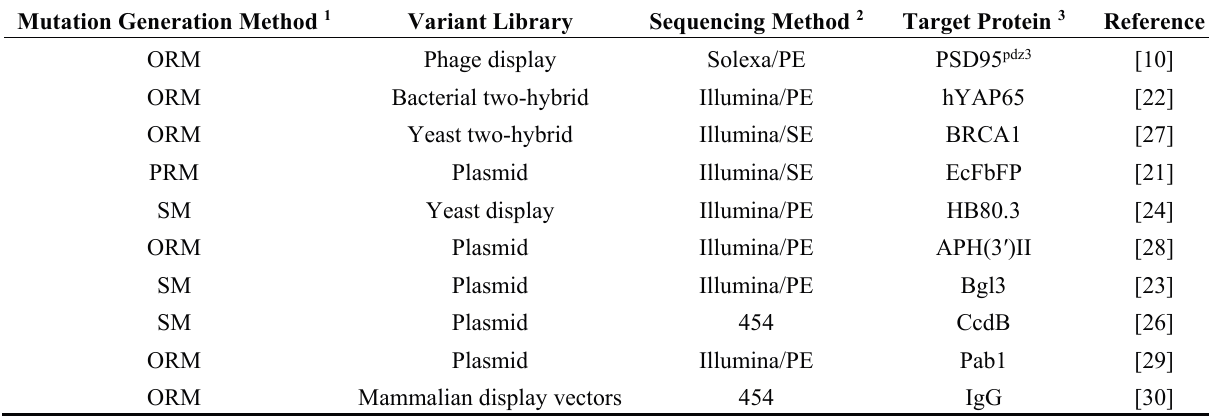
Figure 2. Schematics of the simplified screening systems of the ( a ) conventional strategy of directed evolution, where iterative assays are performed until a desired phenotype appears; and ( b ) deep mutational scanning, where the protein variants are screened to a simpler selection pressure. The different phenotypes of the protein variants are shown by gradient of green colored wells. The desirable phenotypes are shown by darker green colored wells and loss of function is shown by white colored wells. Table 1. Recent studies using deep mutational